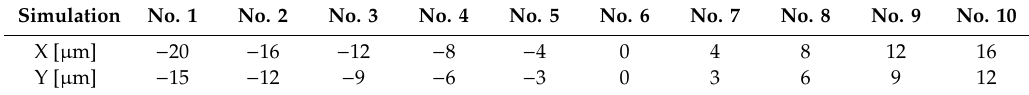
Table 3. Further displacements of the measured points of the 10